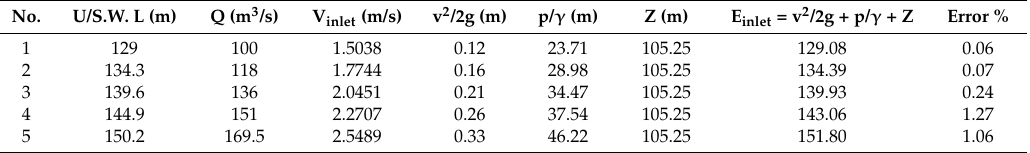
Table 5. Total head with the percent of error calculation at the inlet of the Haditha turbine unit.